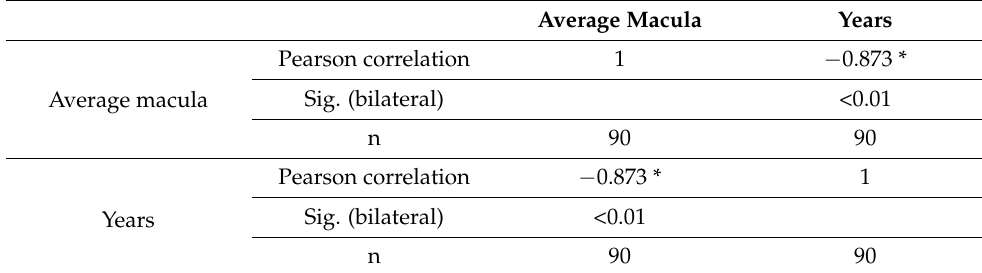
Table 10. Correlation between the number of years since the patient received a CM diagnosis and the mean macular thickness.